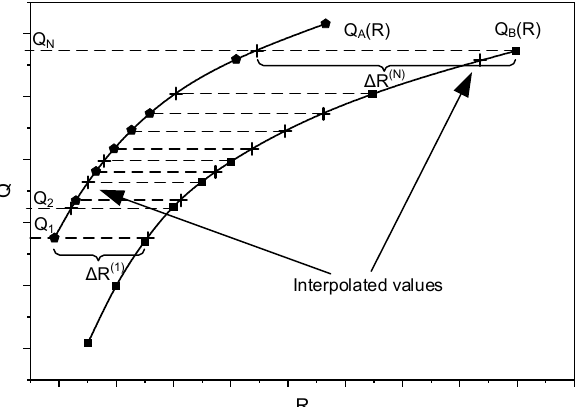
Figure 4. Calculation of the delta rate between the two codecs—based on real video samples and interpolated values.